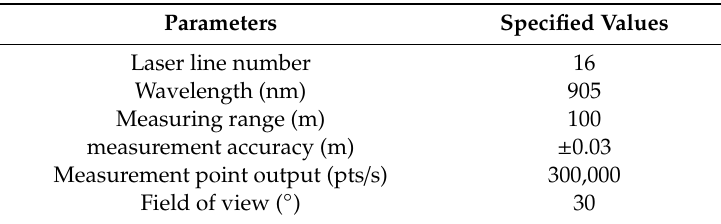
Table 3. Main parameters of the